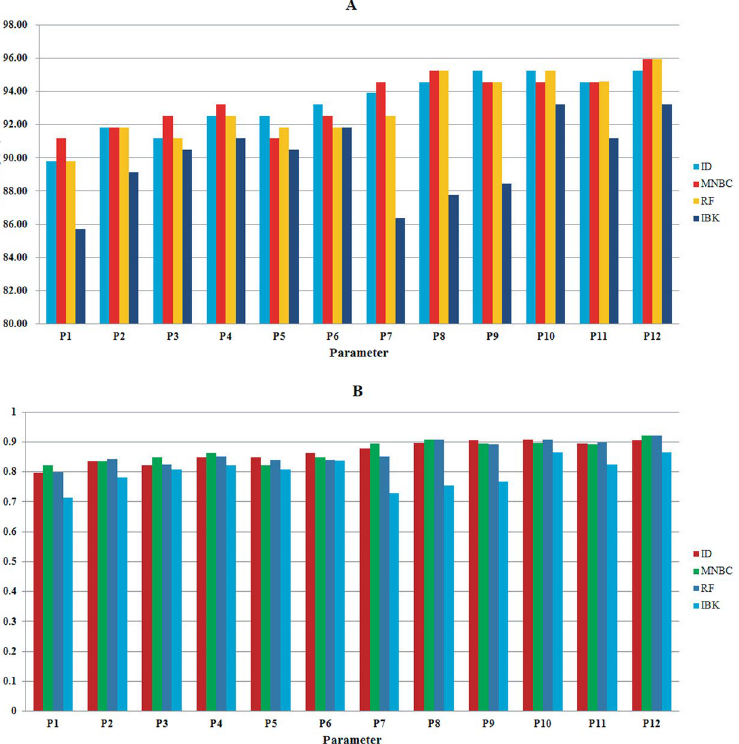
Figure 3. ( A ) Overall predictive accuracies and ( B ) CC values obtained by four different algorithms with 12